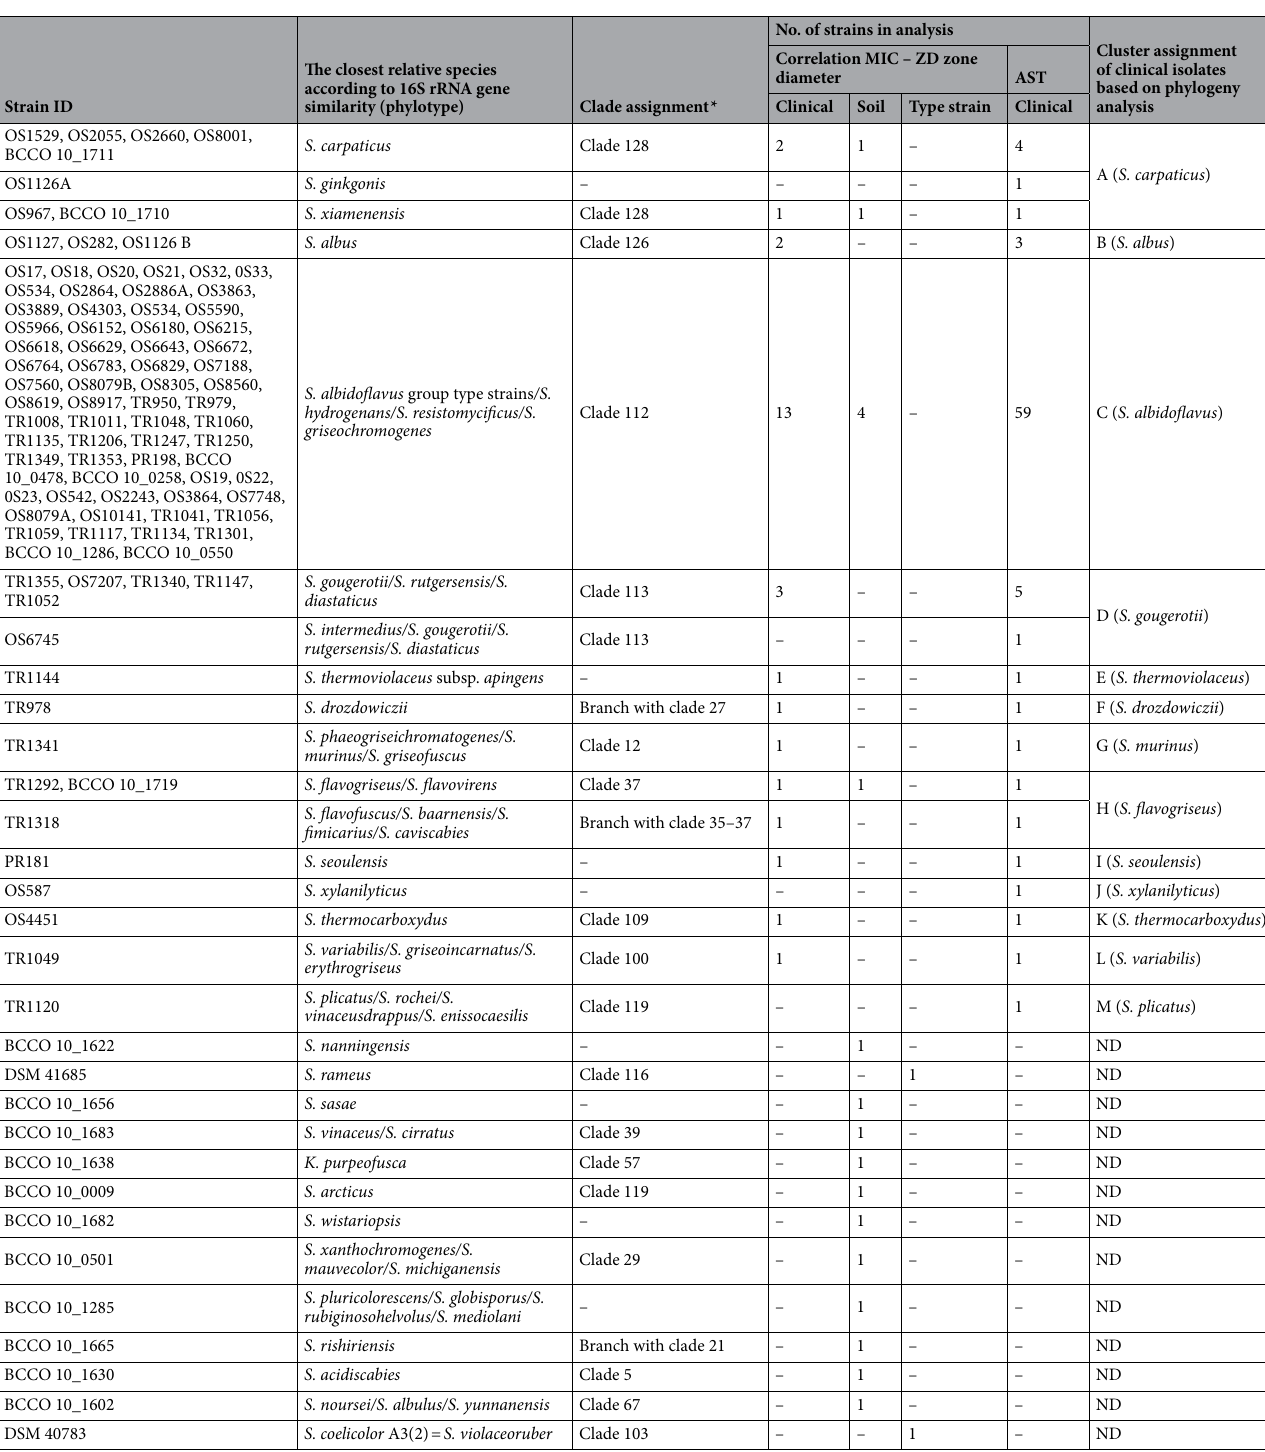
Table 1. List of clinical and soil isolates used in this study. The closest relative species according to 16S rRNA gene similarity referred as phylotype in this study, the clade assignment, number of strains included in the analysis for each category (Correlation of Minimum Inhibitory Concentrations (MIC) and Disk Diffusion (DD) zone diameter, Antibiotic Susceptibility Testing (AST)), and cluster assignment based on phylogeny analysis conducted in this study (Fig. 1). ND – not defined; * Labeda, D. P. et al. Phylogenetic study of the species within the family Streptomycetaceae . Antonie van Leeuwenhoek 101 , 73–104